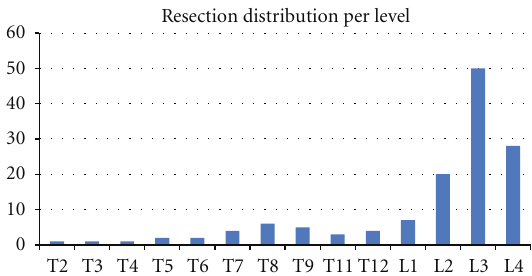
Figure 3: Resection distribution by vertebral